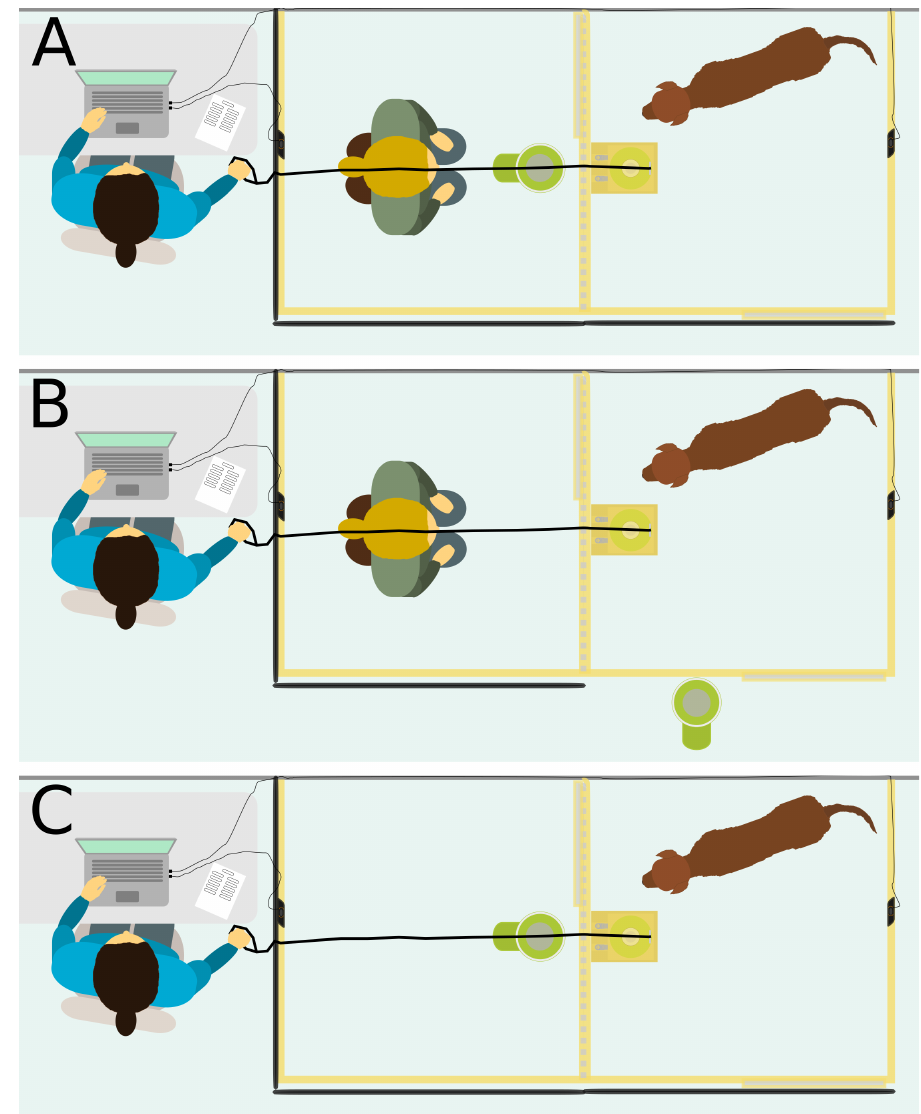
Fig 4. Experimental conditions. A, test condition; B, social facilitation control; C, asocial control. In the test condition, each time the subject pressed the button, food was released from the dispenser and the human ate this. In the social facilitation control, each time the subject pressed the button, food was released from the dispenser but the human could not access it. In the asocial control condition the human was not present. Each time the button was pressed in this condition, food was released but no human ate